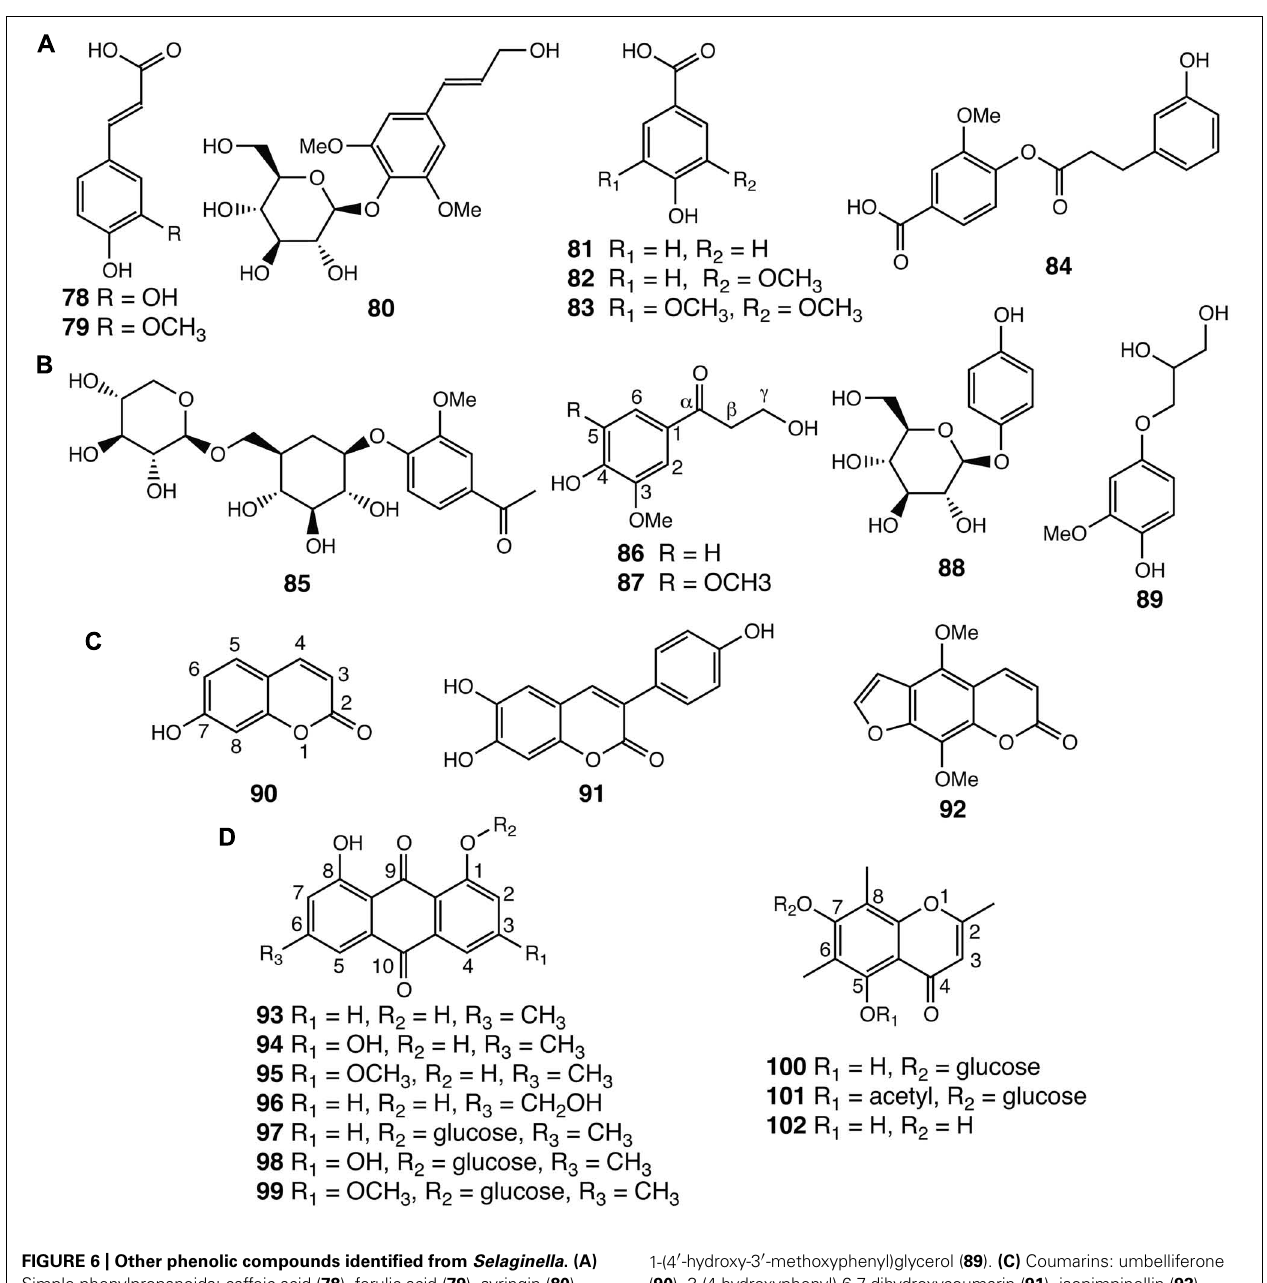
1-(4 (cid:2) -hydroxy-3 (cid:2) -methoxyphenyl)glycerol ( 89 ). (C) Coumarins: umbelliferone ( 90 ), 3-(4-hydroxyphenyl)-6,7-dihydroxycoumarin ( 91 ), isopimpinellin ( 92 ). (D) Anthraquinones and chromones: chrysophanol ( 93 ), emodin ( 94 ), physcion ( 95 ), aloe-emodin ( 96 ), chrysophanol-8- O -glucoside ( 97 ), emodin-8- O -glucoside ( 98 ), physcion-8- O -glucoside ( 99 ), uncinoside A ( 100 ), uncinoside B ( 101 ), and 8-methyleugenitol ( 102